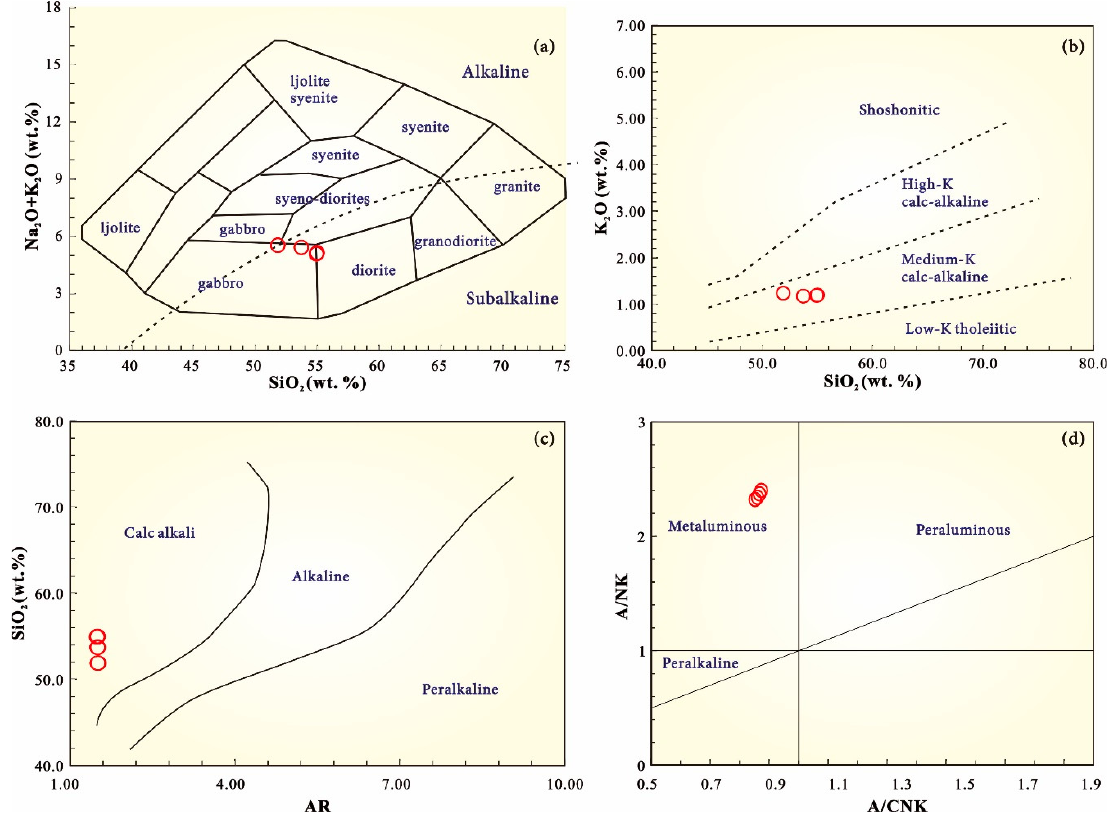
Figure 6. Geochemical diagrams for the hornblende gabbro samples from the Baogeqi gabbro pluton: ( a ) Na 2 O + K 2 O vs. SiO 2 [44]; ( b ) K 2 O vs. SiO 2 [45]; ( c ) A.R vs. SiO 2 [46] , and ( d ) A/CNK vs. A/NK [47].